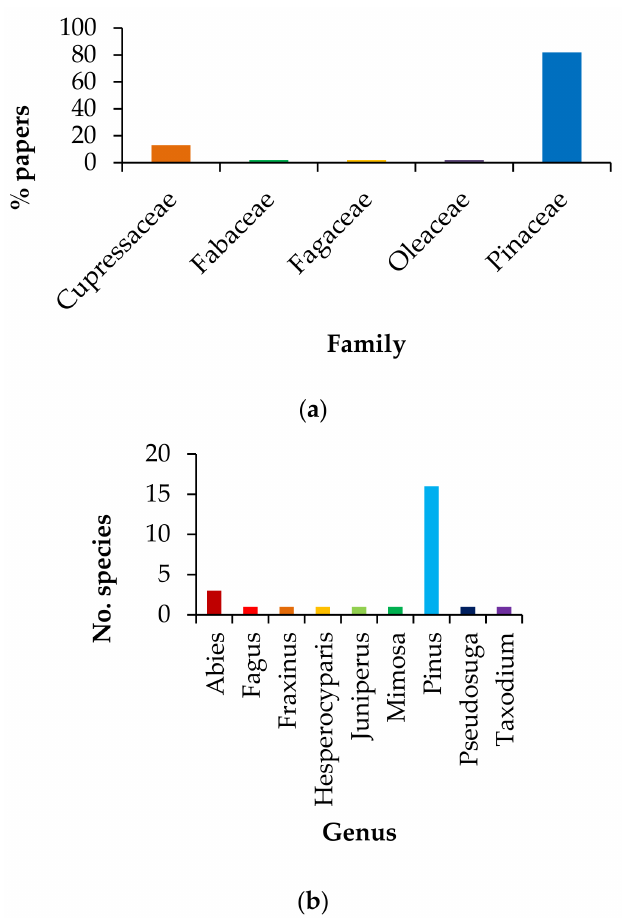
Figure 3. Dendrochronological studies performed in Mexico and grouped, according to ( a ) the taxonomic family and ( b ) the genus of the studied tree